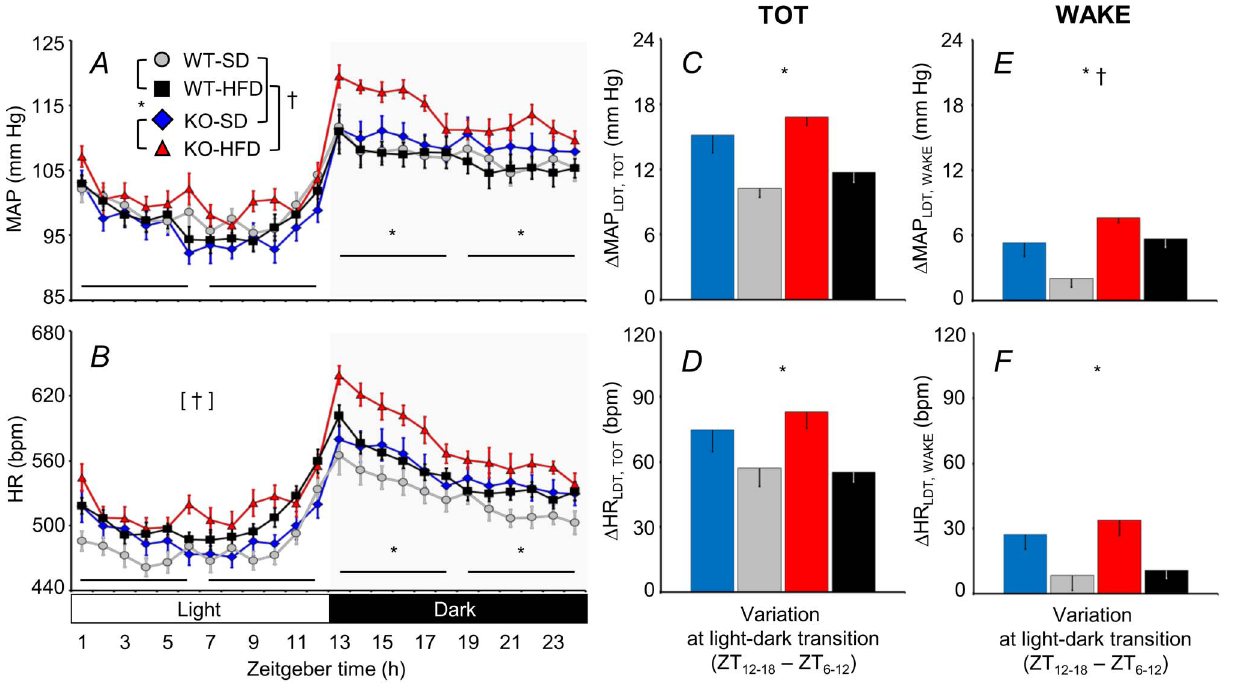
Figure 1. Daily profiles of mean arterial pressure and heart rate. Panels A and B show the daily profiles of mean arterial pressure (MAP) and heart rate (HR). Zeitgeber time (ZT) is time from lights on. The other panels show differences ( D ) in MAP and HR across the light-dark transition (LDT), i.e., between the first six hours of the dark period (ZT12 - ZT18) and the last 6 hours of the light period (ZT6 - ZT12). Panels C and D show data computed regardless of the wake-sleep state (TOT) or exclusively during epochs of wakefulness (WAKE). Data are means 6 SEM for cannabinoid type 1 receptor knock-out mice (KO) and wild-type (WT) mice fed a standard diet (SD) or a high-fat diet (HFD), with n=9–10 per group. The statistical analysis in panels A and B was performed on the average values over 6-hour periods (horizontal lines). * and { , P , 0.05, main effects of genotype (KO vs. WT) and diet (HFD vs. SD), respectively. Symbols within brackets indicate significant main effects (ANOVA). Detailed ANOVA results are reported in Table